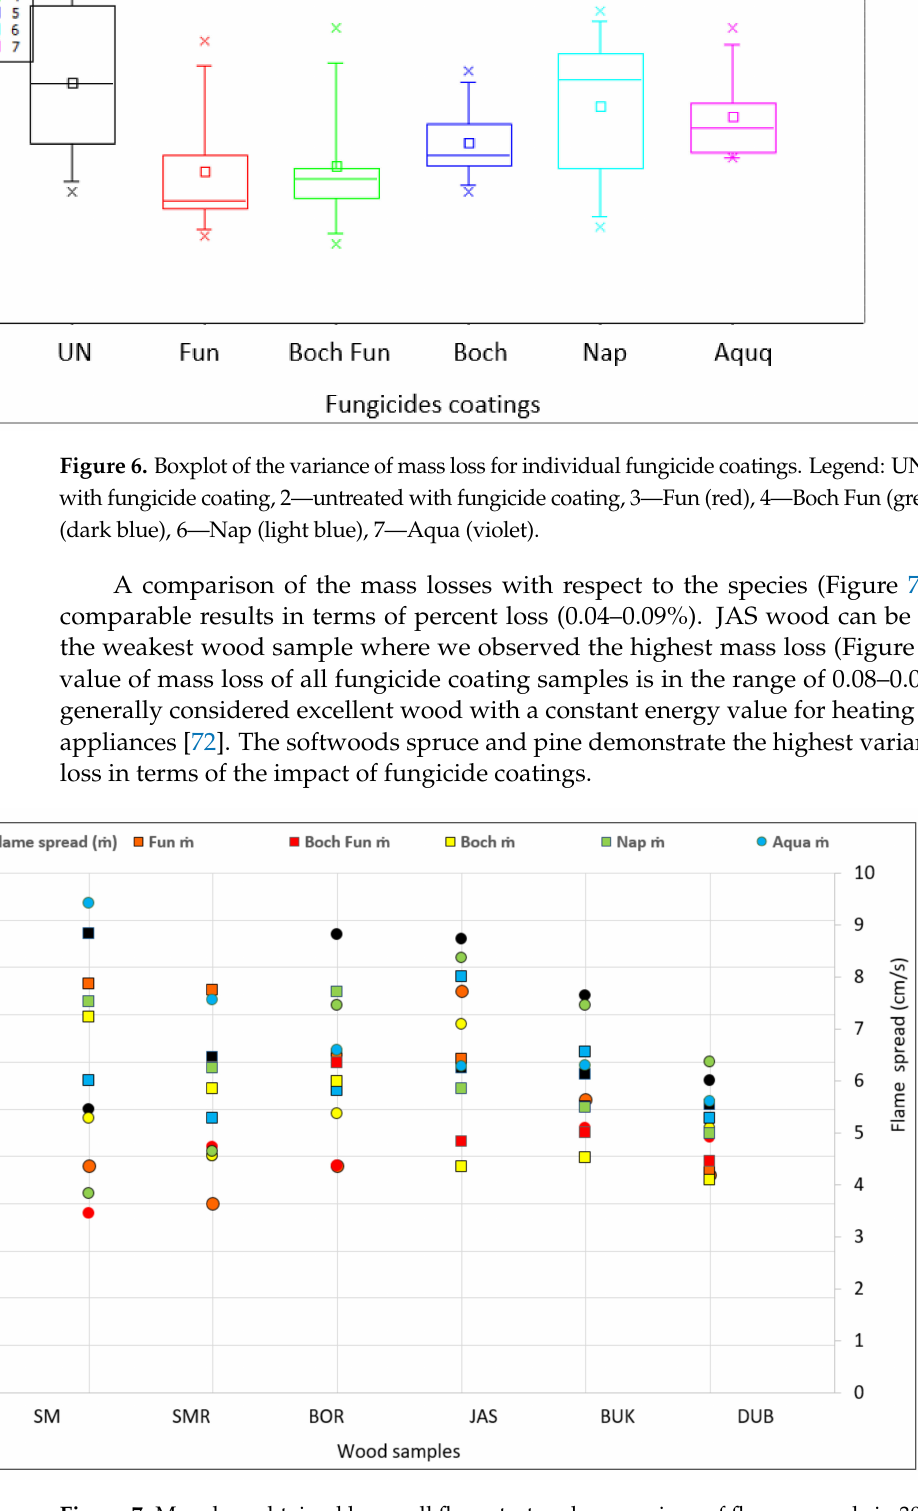
Figure 7. Mass loss obtained by small flame test and comparison of flame spreads in 30